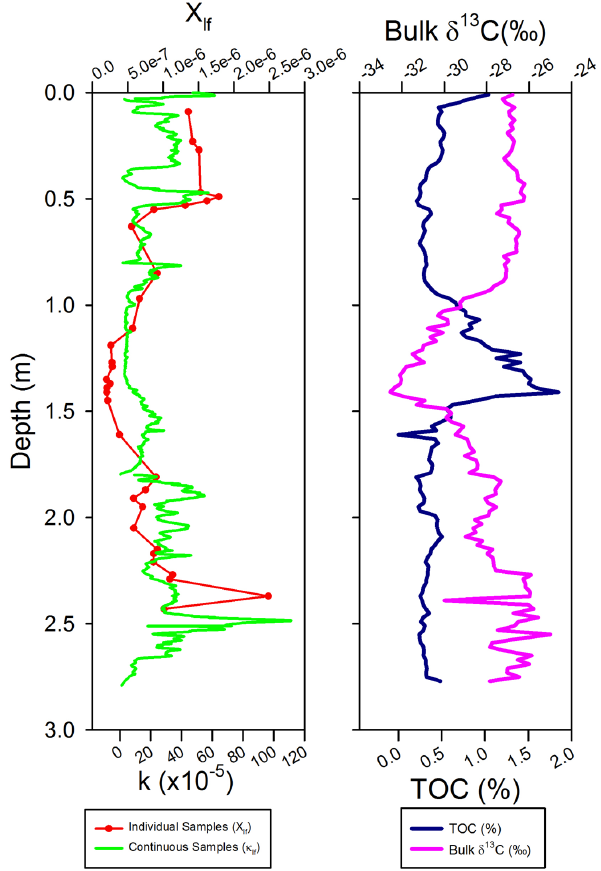
Fig. 5. Comparison of magnetic susceptibility ( χ lf and κ , red and green curves, respectively), bulk δ 13 C org (pink), TOC (purple).